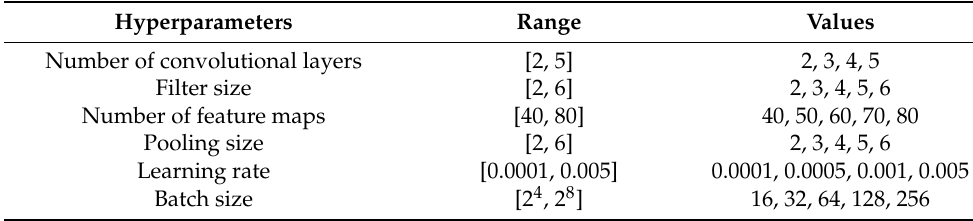
Table 1. The hyperparameters of the proposed CNN model.